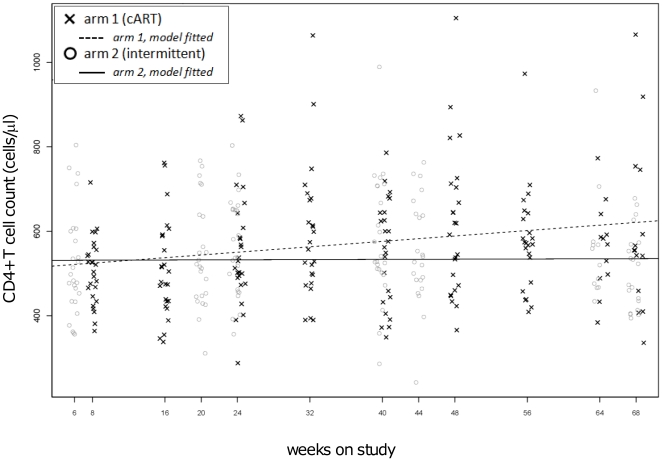
Effect of intermittent ART on CD4 count over time: mixed effect modeling.The effect of time and ARM assignment on CD4+ T cell count was assessed using a Mixed Effect linear model (MEM) as detailed in the text. the continuous lines represent the CD4+ T cell count predicted by the application of the model. Crosses = cART; circles = intermittent ART; dashed line: effect of time and assignment to cART arm; solid line: effect of time and assignment to intermittent ART arm.